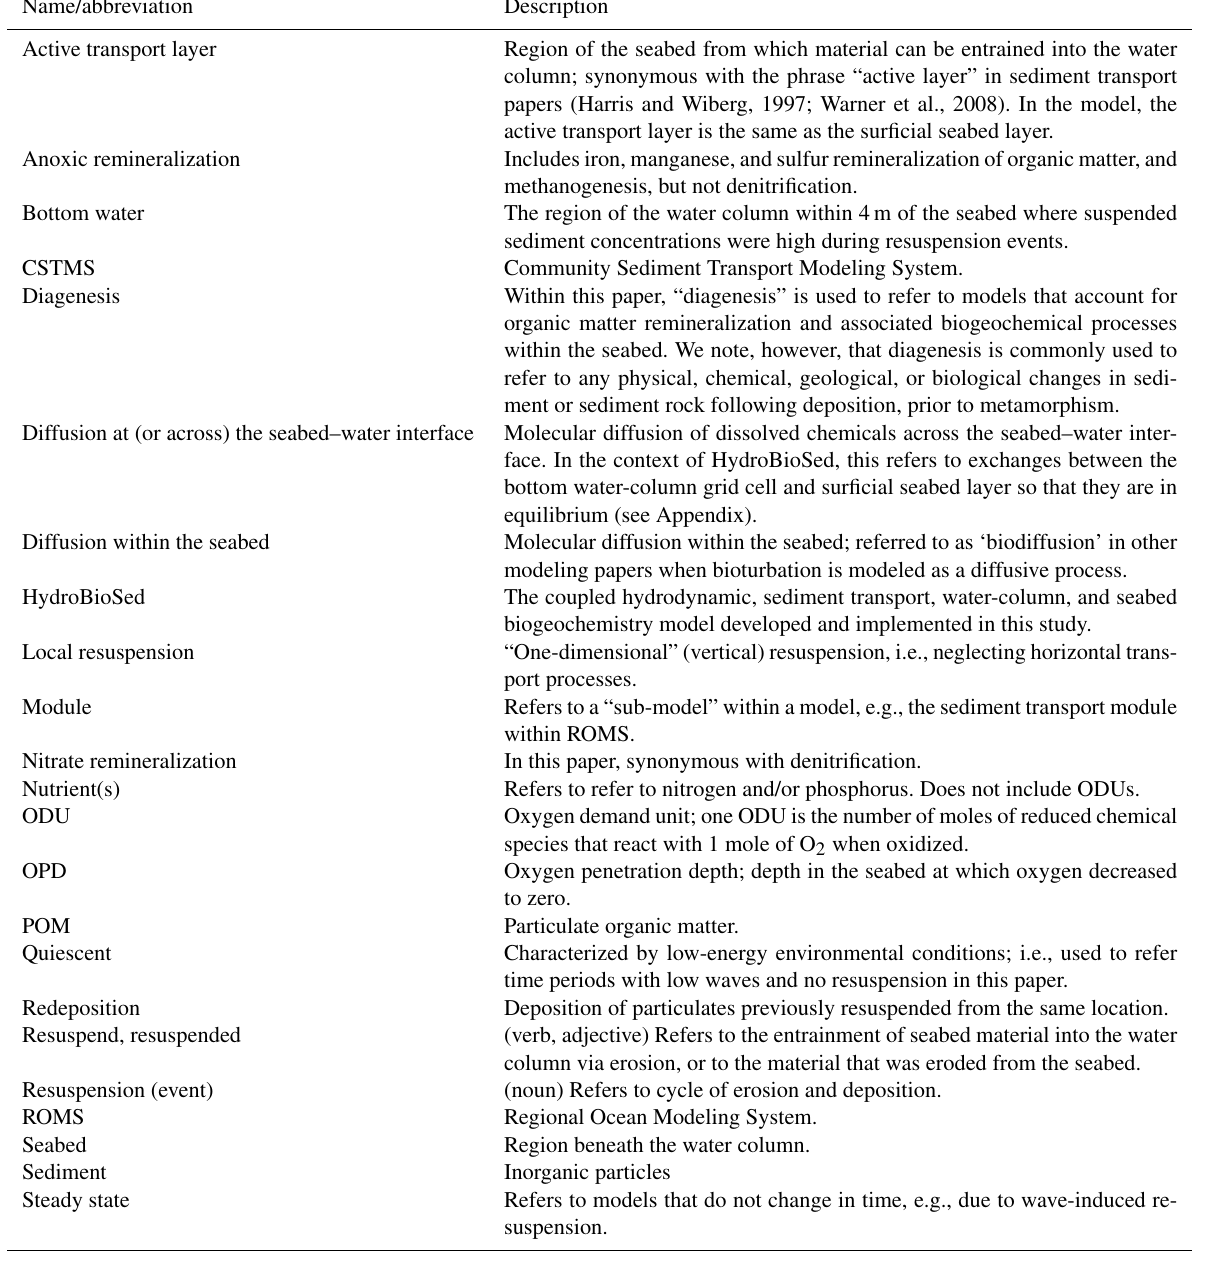
Table 2. Description of phrases, acronyms, and abbreviations, as used in this